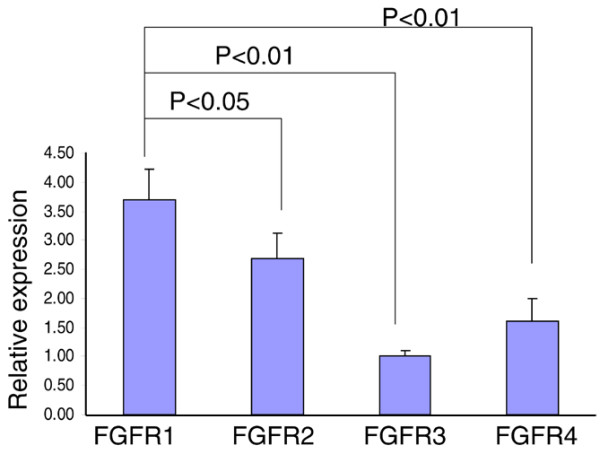
Fibroblast growth factor receptor 1 expression is upregulated in normal bovine nucleus pulposus tissue. Nucleus pulposus cells isolated from bovine intervertebral disc were cultured in a monolayer in 12-well plates at 8 × 105 cells/cm2 for 48 hours and the total RNA was extracted to perform real-time RT-PCR of fibroblast growth factor receptor (FGFR1, FGFR2, FGFR3 and FGFR4) genes. Error bars represent three different donors in three separate experiments.